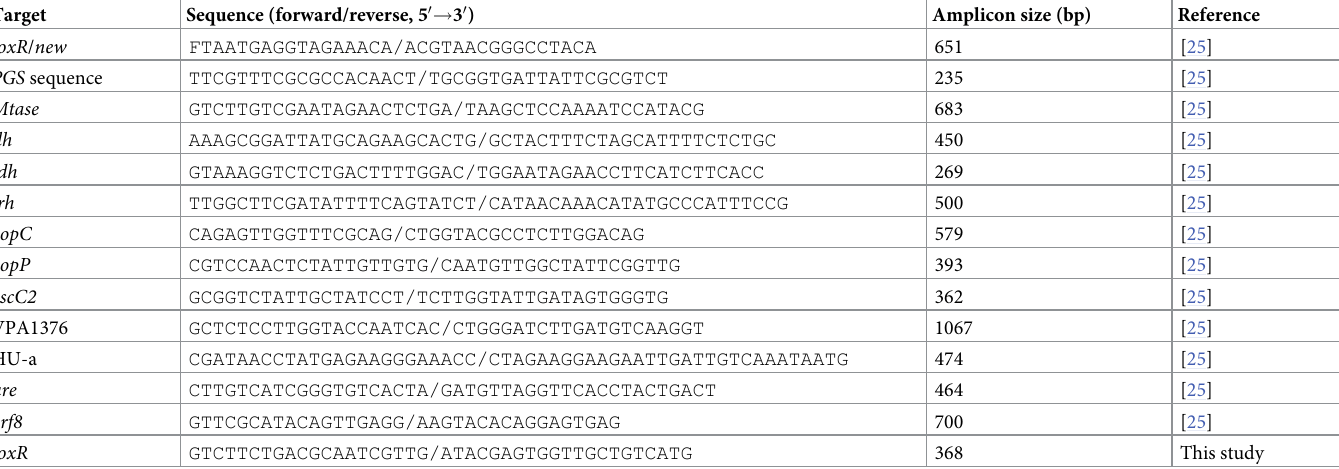
Table 1. Primers used in this study.